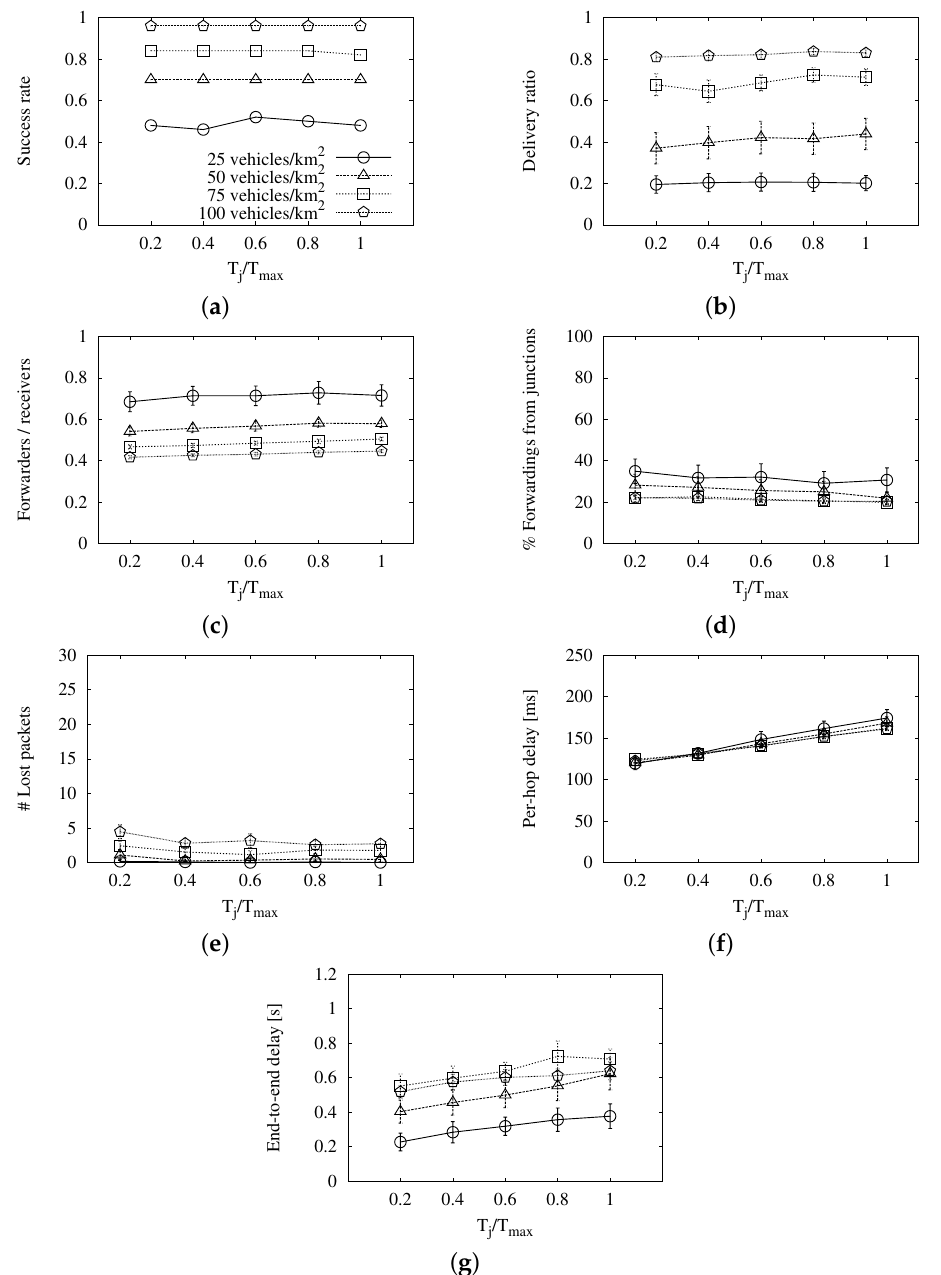
Figure 4. Results of the map-based scheme with fixed T max and different T j values in the New York scenario: ( a ) long-reach success rate; ( b ) delivery ratio; ( c ) forwarding ratio; ( d ) portion of relays from junctions; ( e ) number of lost packets; ( f ) average per-hop delay; ( g ) average end-to-end